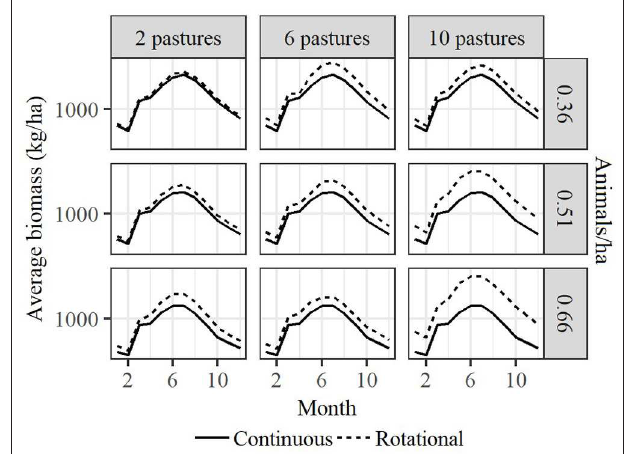
FIGURE 5 | Monthly simulated standing biomass in continuous (solid line) vs. rotational grazing (dashed line) simulations. Sub-plots show number of pastures (2–10) in rotation, and total ranch-level stocking rate (0.36–0.66 animals/ha). All simulations were run for 5 years, but for clarity only the final 12 months are shown here. Intra-annual patterns were similar across all 5 years (see Supplemental Figure 5 for full results across all simulated